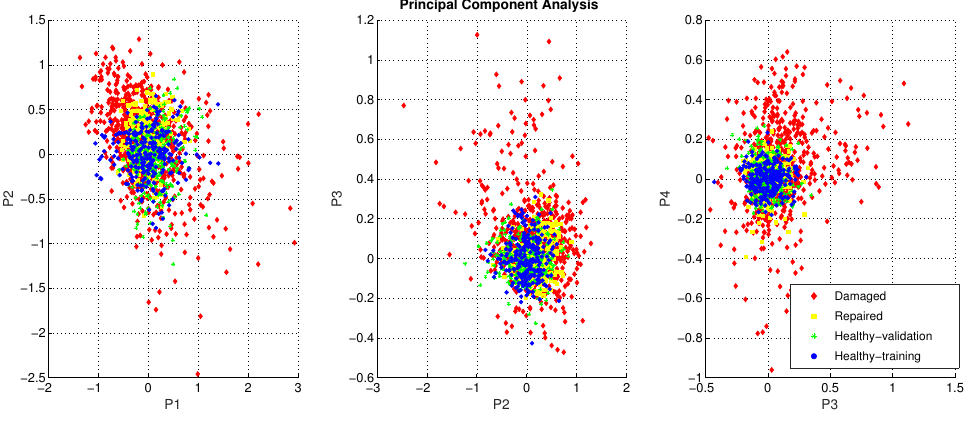
Figure 9. The data set projected on principal planes computed via